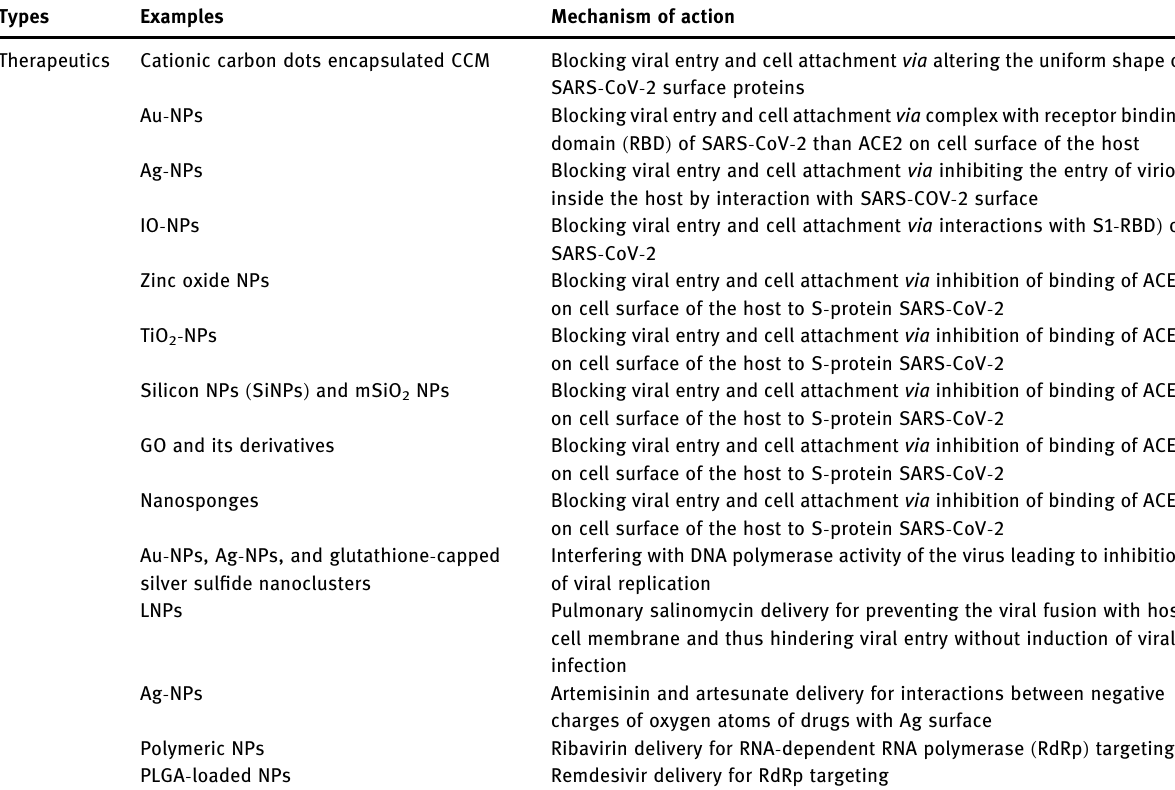
Table 2: Proposed mechanism of action of nanoparticles used in COVID - 19 therapy